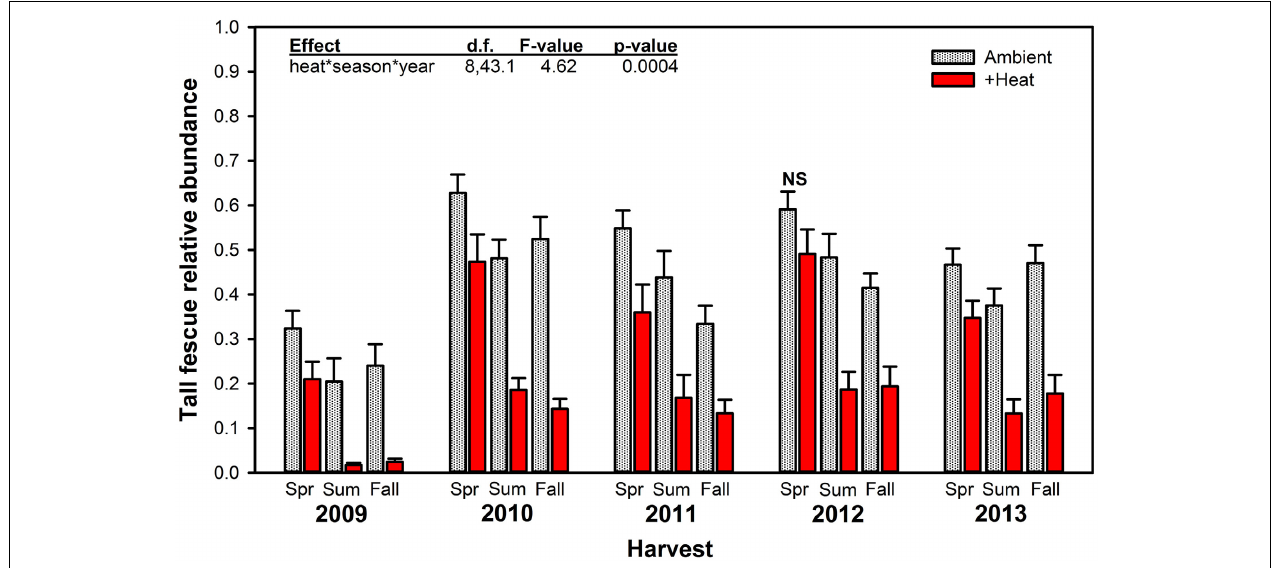
FIGURE 2 | Average ( ± SE) relative abundance of tall fescue (g tall fescue biomass/g total biomass) measured in heated ( + 3 ◦ C) vs. non-heated, ambient temperature treatments at every harvest period (Spring, Summer, and Fall) for all 5 years of the study. The